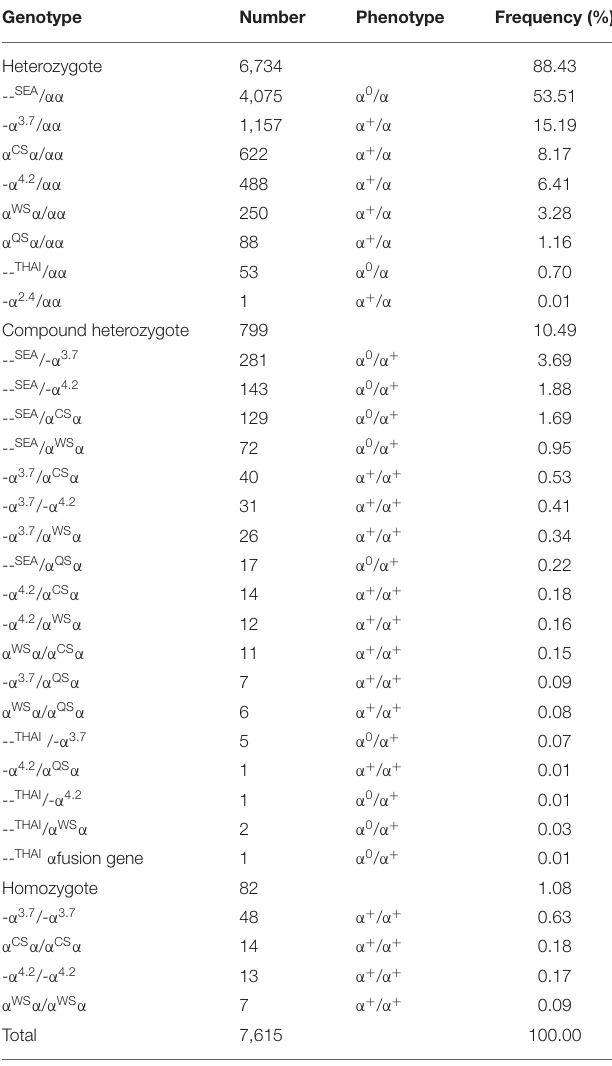
TABLE 1 | Distribution of genotypes among the 7,615 α -thalassemia children in Guangxi. Genotype